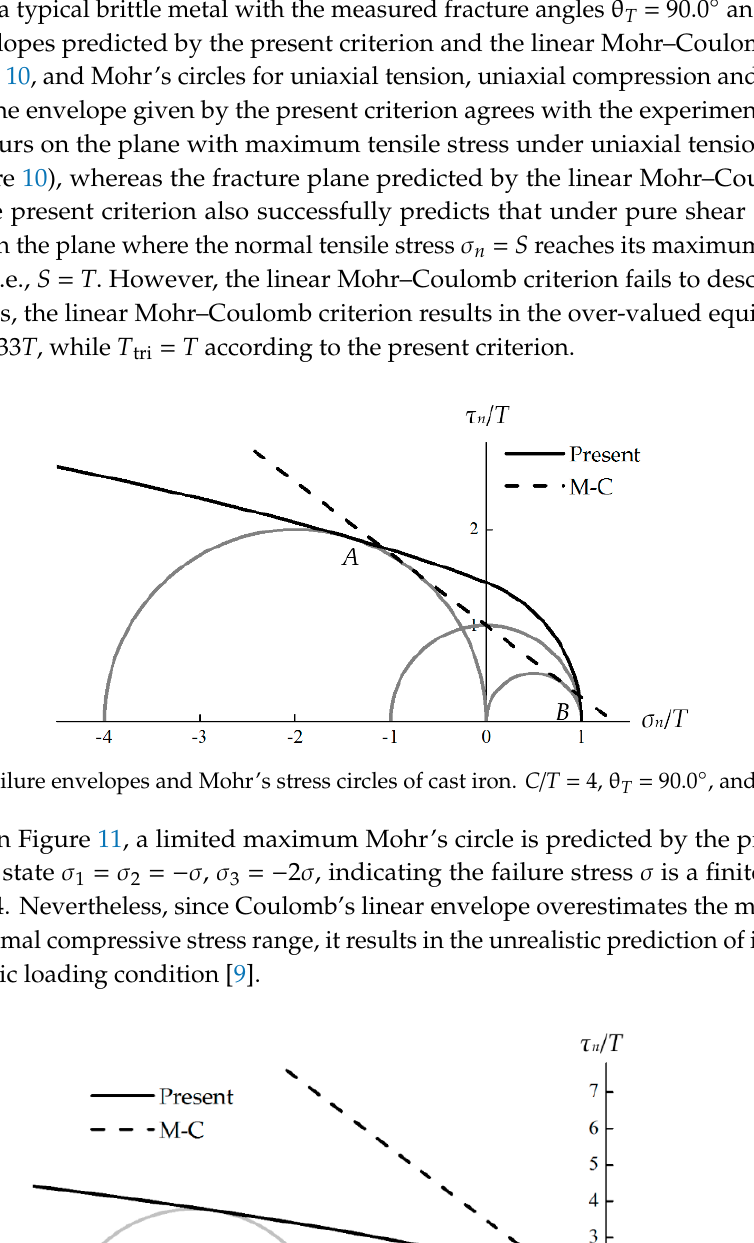
Figure 9. Failure envelopes and the experimental data of metallic glass [7]. T = 1660 MPa, C = 1843 MPa, θ T = 50.7°, and θ C = 43.0°.